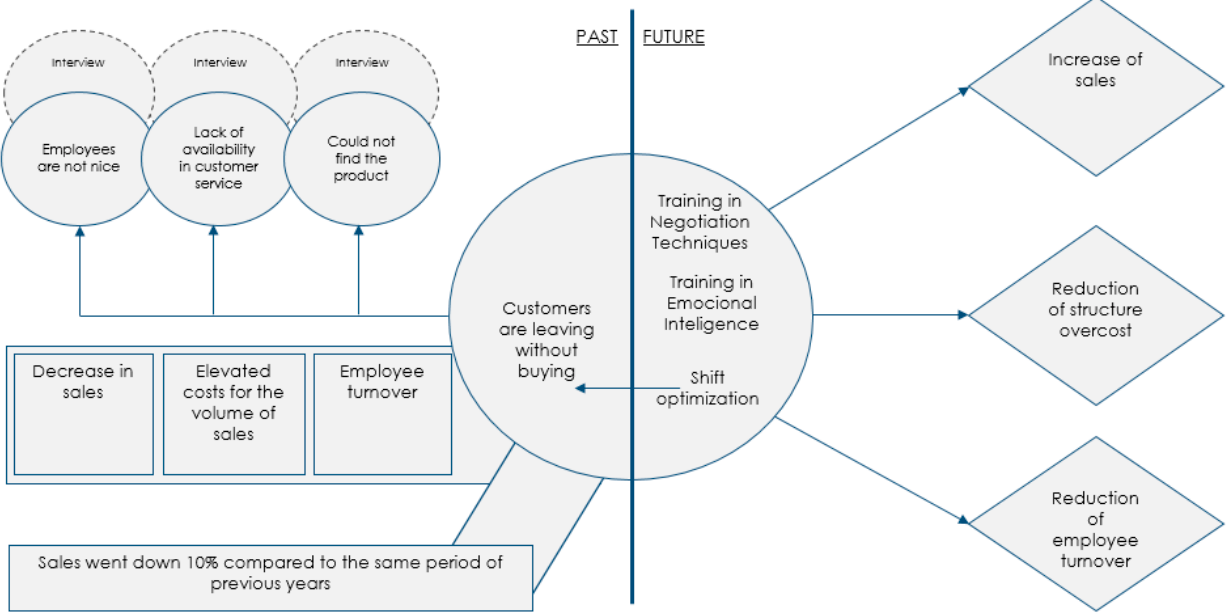
13 of 17 Figure 11. Example of negative correlation between variables (authors).